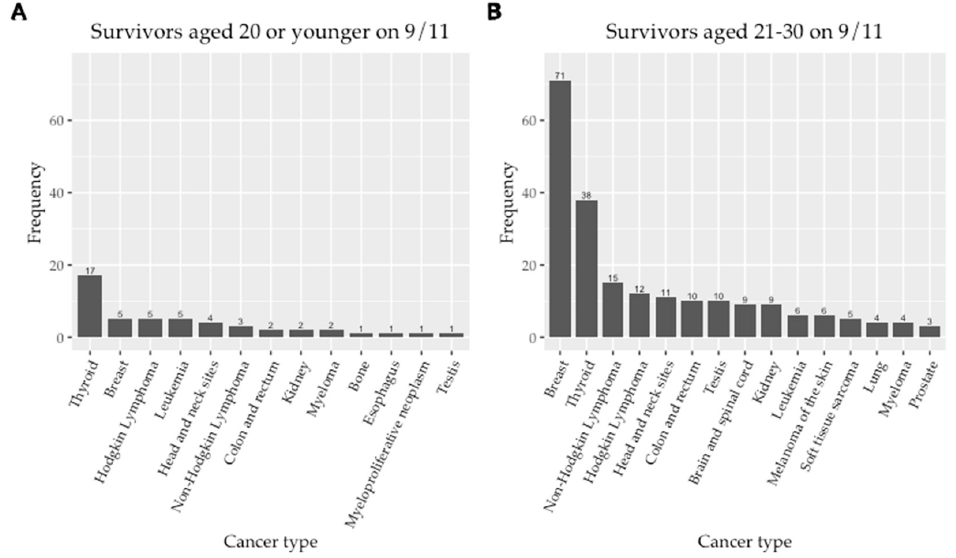
Figure 3. ( A ) Frequency of all cancer diagnoses (total 13 types) in EYA aged 20 or younger on 9/11; ( B ) Frequency of top fifteen cancer diagnoses in EYA aged 21–30 on 9/11 included in the WTC EHC cancer analysis. The frequency distribution of the cancers differed between male and female EYA (Figure 4). Among EYA women diagnosed with cancer, breast cancer was the most com- mon cancer diagnosis (42.8% of cancers in women), followed by thyroid (24.2%), non-